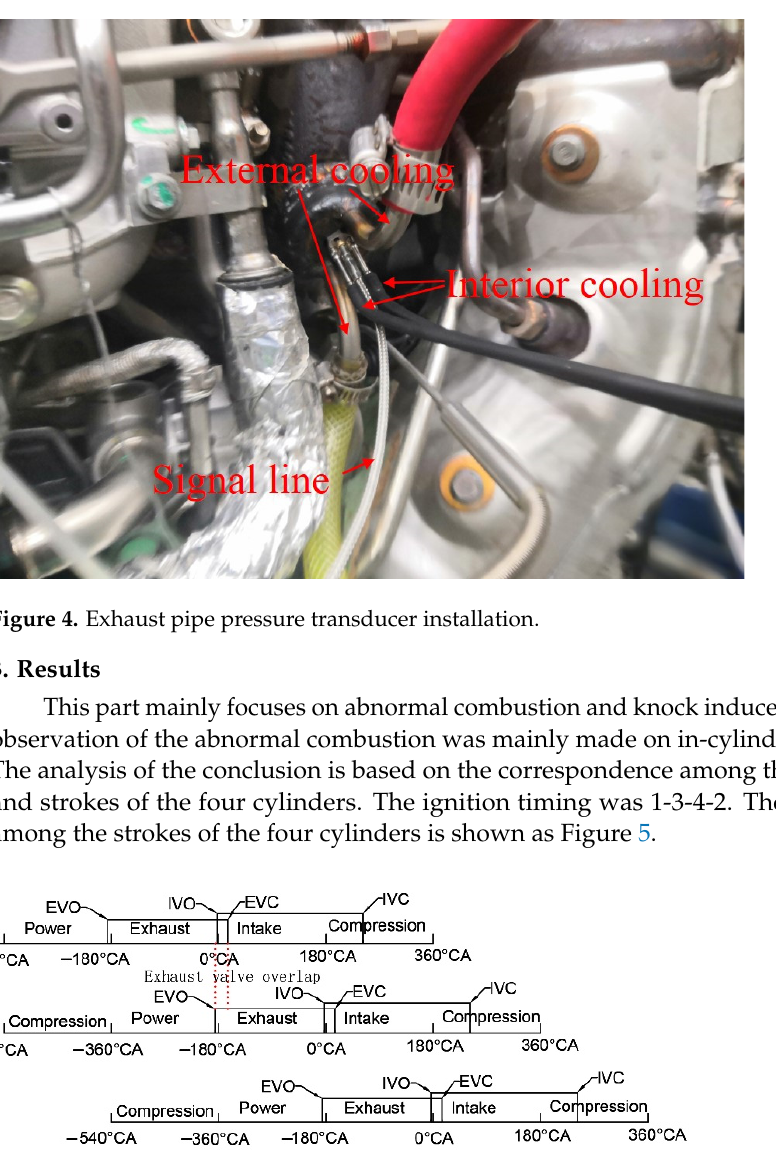
Figure 4. Exhaust pipe pressure transducer installation.